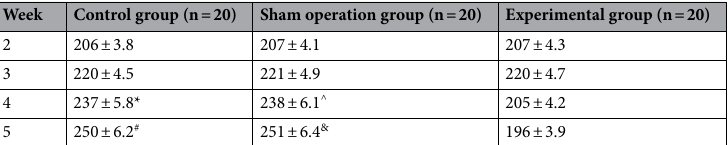
Table 2. Body mass (g). * P < 0.05 compared with the experimental group, ^ P < 0.05 compared with the experimental group, # P < 0.05 compared with the experimental group, & P < 0.05 compared with the experimental group. After 2 weeks the rats in experimental group ate less, and their weight was significantly reduced compared with the other two groups.